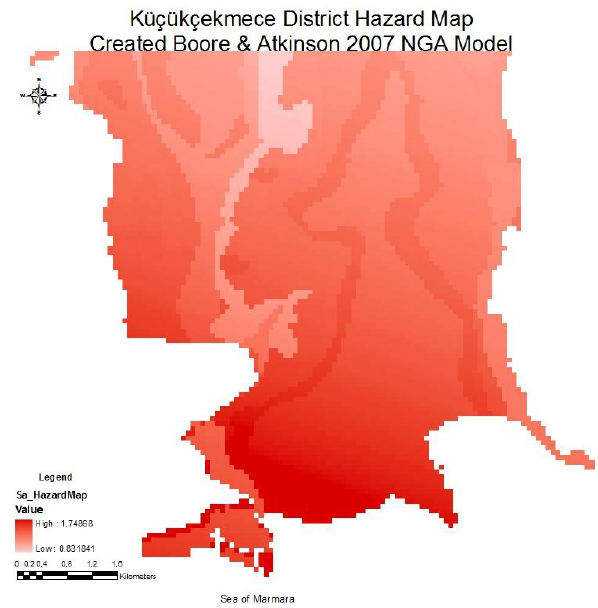
Figure 5 Hazard map created by Boore & Atkinson (2007) attenuation relation 9 Fig. 5. Hazard map created by Boore and Atkinson (2007) attenua- tion